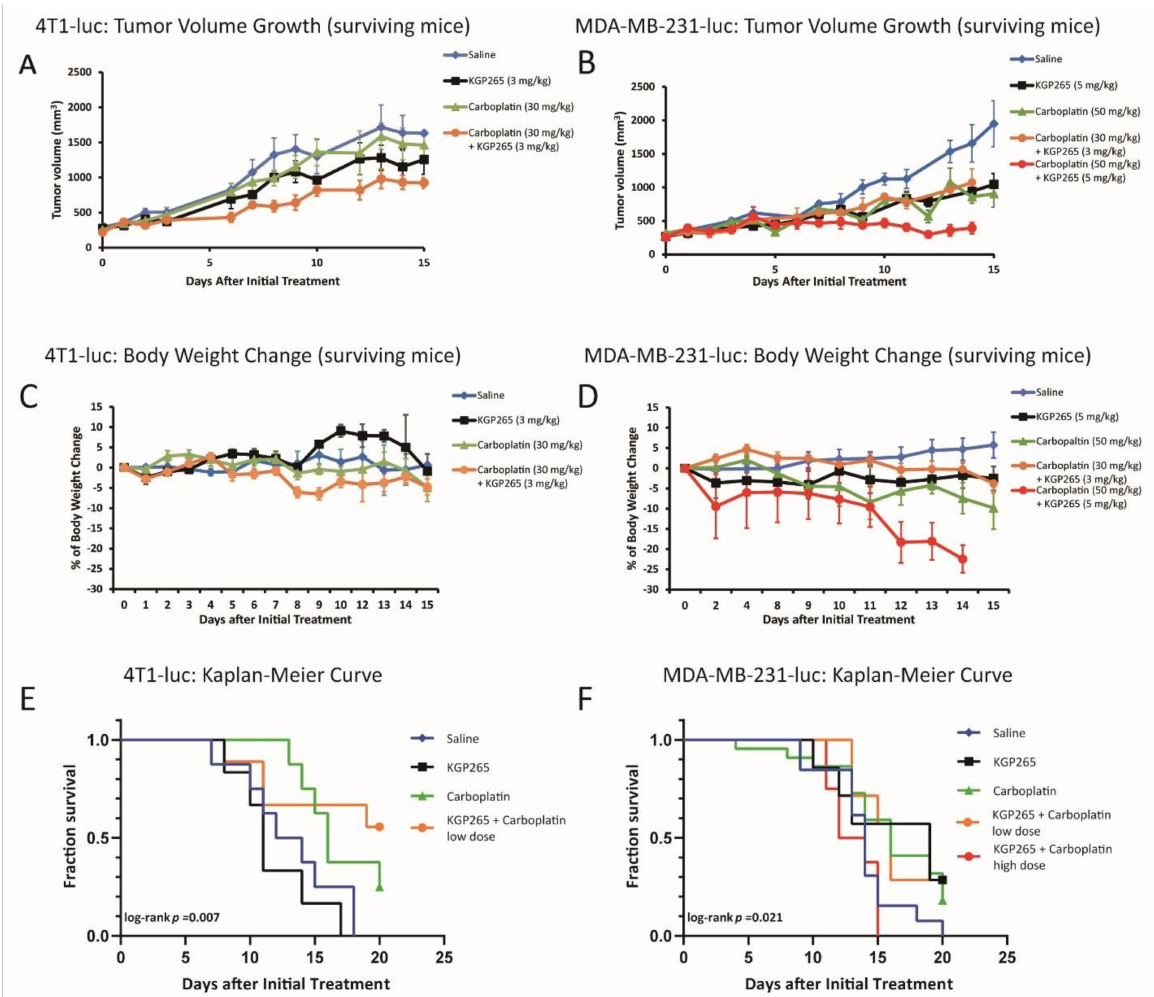
Figure 9. Comparison of the tumor growth curves, body weight loss and Kaplan-Meier survival curves for the therapeutic cohorts. ( A ) Growth curves for the groups of 4T1-luc tumors in the mammary fat pad of BALB/C mice: saline control (blue, n = 6), KGP265 (3 mg/kg) (black, n = 4), carboplatin (30 mg/kg) (green, n = 8) and carboplatin (30 mg/kg) + KGP265 (3 mg/kg) (orange, n = 6). All groups represented only mice surviving over the whole time course. The bars represent the SEM. ( B ) Growth curves for the groups of orthotopic MDA-MB-231-luc tumors growing in the mammary fat pad of NOD/SCID mice: saline control (blue, n = 13), KGP265 (5 mg/kg) (black, n = 7), carboplatin (50 mg/kg) (green, n = 22), carboplatin (30 mg/kg) + KGP265 (3 mg/kg) (orange, n = 8) and carboplatin (50 mg/kg) + KGP265 (5 mg/kg) (red, n = 8). All groups showed the surviving mice. The bars represent the SEM. ( C ) The mean change in the body weights for the cohorts of BALB/C mice bearing orthotopic 4T1-luc tumors in the mammary fat pad. All the agents were administered twice-weekly: saline control (blue), KGP265 (3 mg/kg) (black), carboplatin (30 mg/kg) (green) and carboplatin (30 mg/kg) + KGP265 (3 mg/kg) (orange). ( D ) The mean change in the body weights for the cohorts of NOD/SCID mice bearing orthotopic MDA-MB-231-luc tumors in the mammary fat pad. All the agents were administered twice-weekly: saline control (blue), KGP265 (5 mg/kg) (black), carboplatin (50 mg/kg) (green), carboplatin (30 mg/kg) + KGP265 (3 mg/kg) (orange) and carboplatin (50 mg/kg) + KGP265 (5 mg/kg) (red). ( E ) Kaplan-Meier survival curves for the groups of 4T1-luc tumors: saline control (blue), KGP265 (3 mg/kg) (black), carboplatin (30 mg/kg) (green) and carboplatin (30 mg/kg) + KGP265 (3 mg/kg) (orange). ( F ) Kaplan-Meier survival curves for the groups of MDA-MB-231-luc tumors: saline control (blue), KGP265 (3 mg/kg) (black), carboplatin (30 mg/kg) (green), carboplatin (30 mg/kg) + KGP265 (3 mg/kg) (orange) and carboplatin (50 mg/kg) + KGP265 (5 mg/kg)